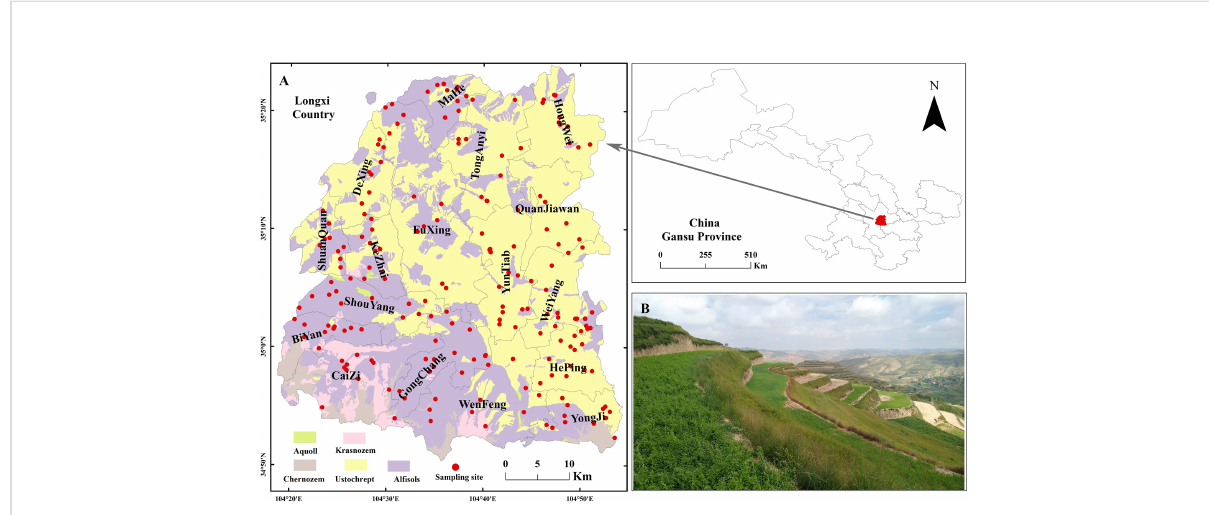
FIGURE 1 Spatial arrangement of the sampling sites in Longxi County, Gansu, northwest China. The left panel shows the map of the soil types, the distribution of townships, and the sampling sites with red solid cycle (A) and bottom-right panel is the typical landscape and topography in research area (B)